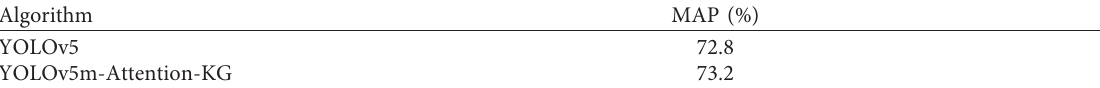
Table 3: Parameters of detection results of each